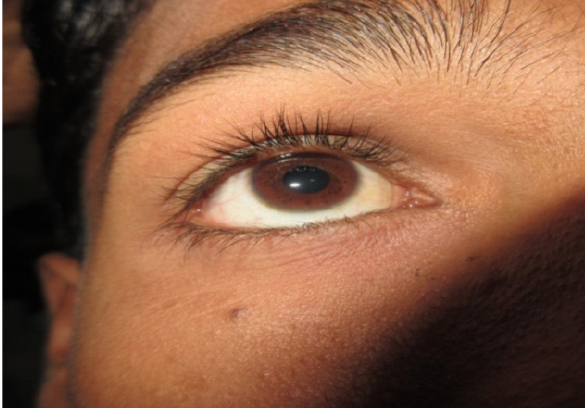
Fig.3. Complete removal of lice and nits. Fig.2. Microscopic appearance of crab louse and